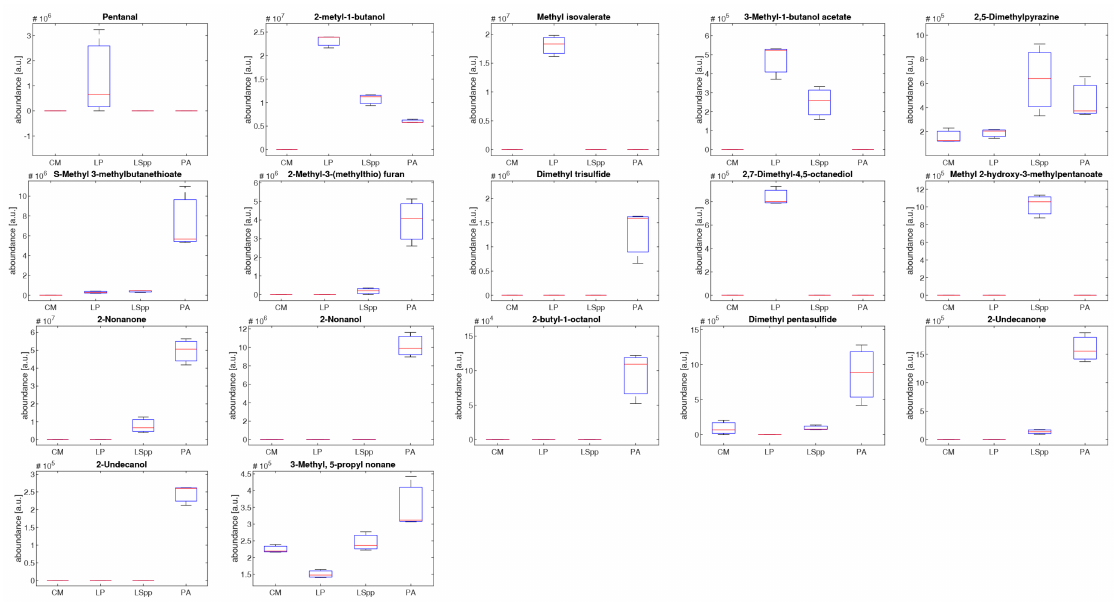
Figure 8. Boxplot representing the distribution of different characteristic compound abundances for the different kinds of cultures: BYE α broth (CM), L. pneumophila (LP), L. species (LSpp) and P. aeruginosa